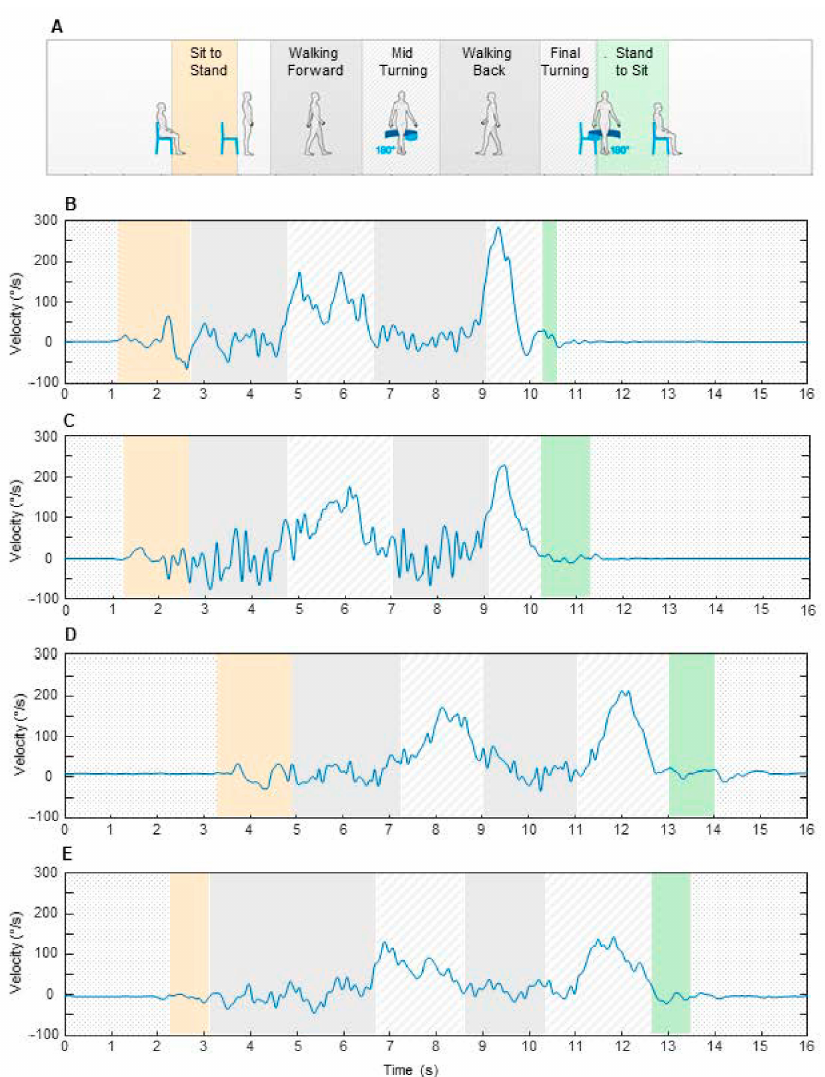
Figure 1. Subcomponents of instrumented timed up and go (iTUG) test measured in the experiments ( A ). The plots represent examples of angular velocity profiles and components duration observed in a child ( B ), a young adult ( C ), a senior adult ( D ), and an elderly person ( E ). The data are relative to the test performed along 3